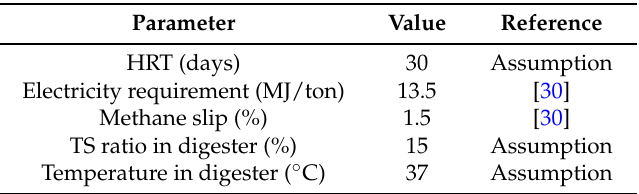
Table A7. Process data on anaerobic digestion. HRT: hydraulic retention time.